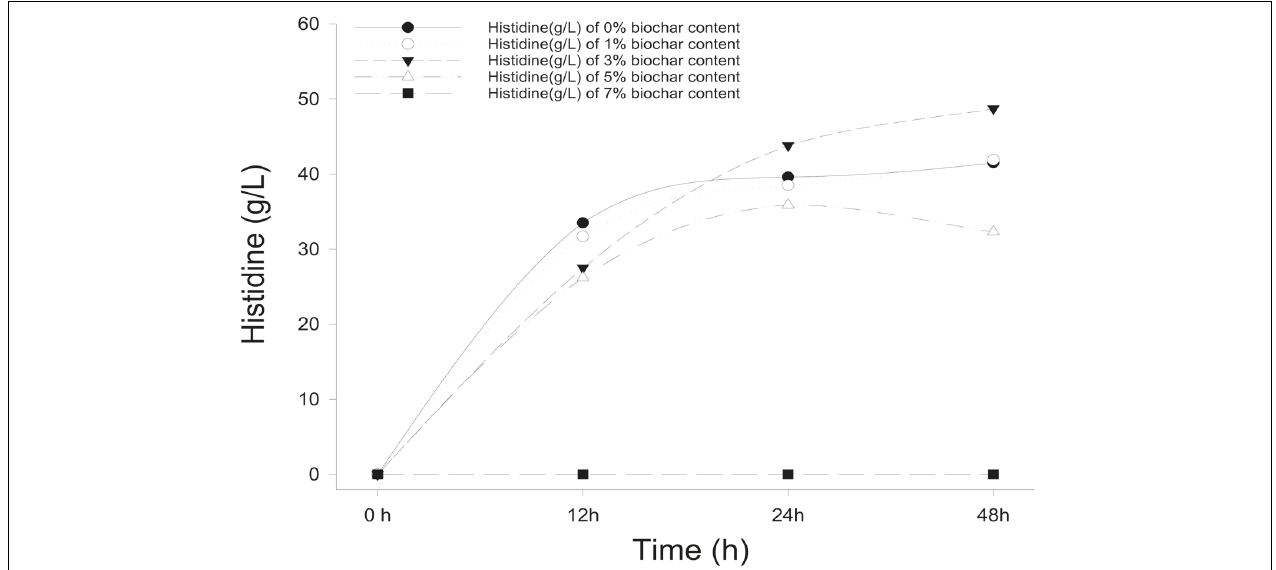
FIGURE 1 | The concentration of L-histidine production in E. coli with different biochar concentrations and treatment times.